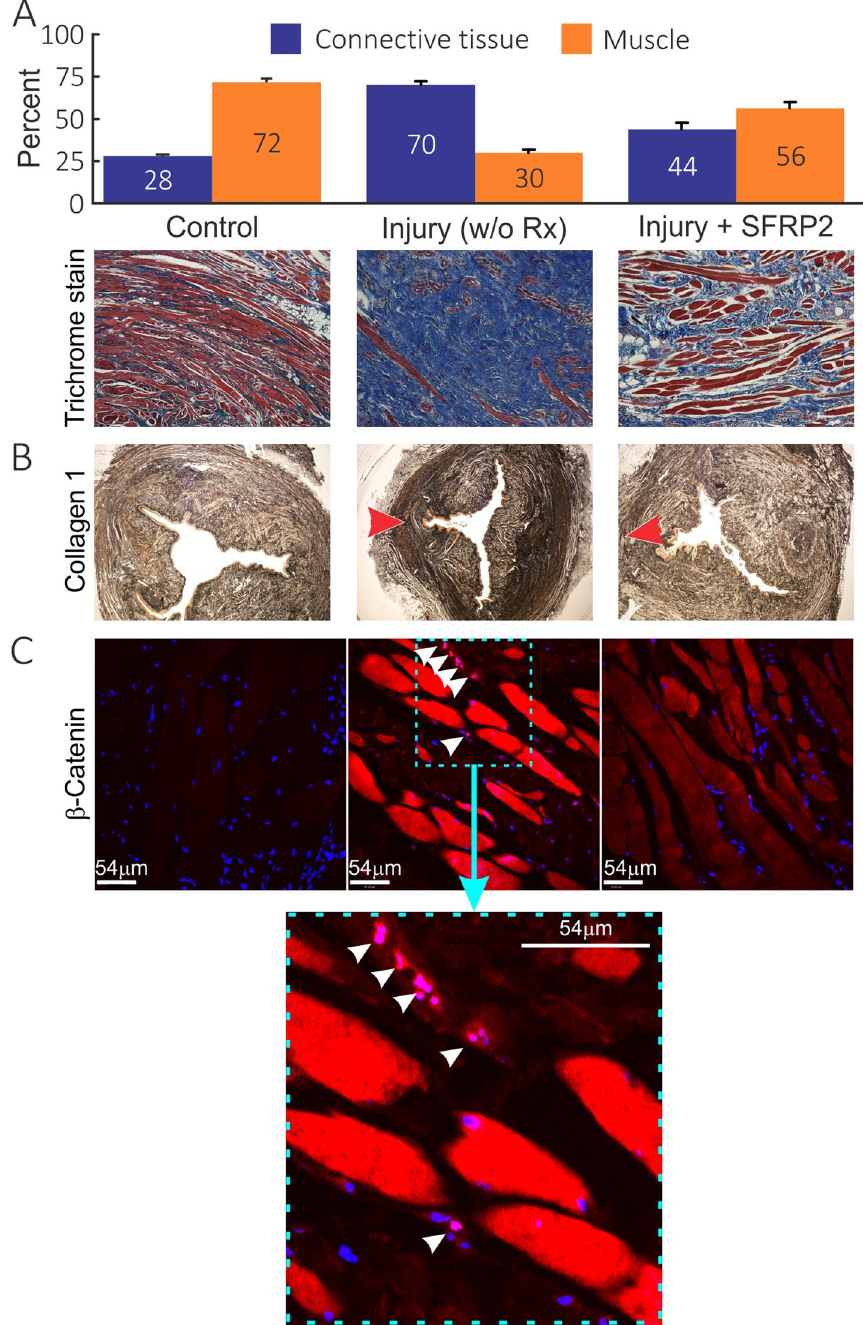
Figure 2. ( A ) Masson- trichrome stained rabbit EAS tissues from uninjured control (left), injured and treated with placebo (middle), injured and treated with sFRP-2 at 15 weeks post-myotomy. Histological evidence of sustained and widespread fibrosis is demonstrated with Masson- trichrome stain in placebo treated animals. The EAS muscle is stained in red and connective tissue in blue in these images. A significant increase in connective tissue and a decrease in muscle was observed in untreated animals (P < 0.05) compared to uninjured controls (n = 3–4 from each group). ( B ) Photomicrographs of rabbit anal canal cross sections showing collagen-I protein expression from control (left), injured and treated with placebo(middle), injured and treated with sFRP-2 at 15 weeks post-myotomy. Increased collagen (intense brown) is seen in tissues from animals treated with placebo and this increase was attenuated in sFRP-2 treated rabbits. Red arrows indicate site of surgical myotomy. ( C ) Photomicrographs of rabbit anal canal cross sections showing β -catenin protein expression from control (left), injured and treated with placebo (middle), injured and treated with sFRP-2 at 15 weeks post-myotomy. Increase in β -catenin nuclear activation (white arrow heads) is seen in tissues from animals treated with placebo and this increase was attenuated in sFRP-2 treated rabbits. Inset shows nuclear